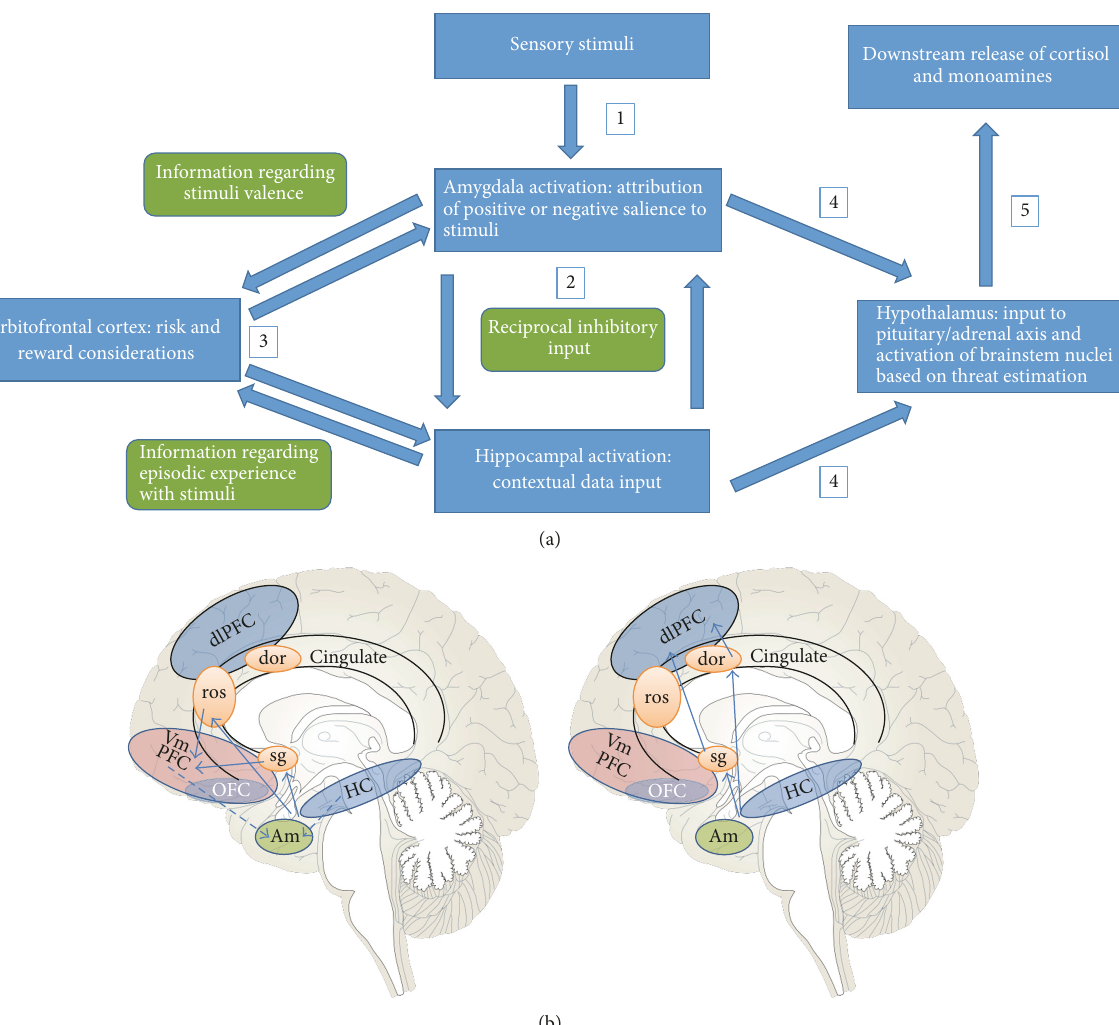
Figure1:Depictionofthesubcortical-corticalcommunicationwhichwillinformwhetherthedlPFCorvmPFCwillbepreferentiallyactivated in response to environmental stimuli. (a) shows how, as the individual perceives an element in the environment (the thalamus is not portrayed in this figure), the amygdala will be activated, and positively or negatively valenced associations will emerge based on past experience. The hippocampus will provide some level of contextual data based on episodic memory, and the OFC will weigh risk and reward considerations based on input from these two structures. Subsequent neuroendocrine responses will ensue, with the hypothalamus being more or less driven to initiate downstream cortisol release, as well as stimulating brainstem nuclei for release of monoamines, depending on the subjective sense of danger felt to be present. (b) illustrates the subsequent higher cortical level activation that will occur after this initial communication. The subcortical-cortical connection will be mediated by the ACC (either ventral or dorsal portions), which will divert activation preferentially towards the dl or vmPFC. Left panel: in instances of lower perceived environmental threat, the vmPFC is activated via portions of the sgACC and the rACC; there is greater inhibitory connection with the amygdala, thus allowing for greater top-bottom mitigation of the fear response (also aided by the inhibitory contextual hippocampal input); more robust development of the vmPFC-amygdala and hippocampus-amygdala control mechanisms can allow for more controlled responses to the environment, even when there may be potential threat, as cognitive control and contextual data will prevent excessive reactivity and stimulus generalization, permitting greater flexibility and hence more adaptive responses. The vmPFC has been shown to be hypoactive in cases of child abuse, major depressive disorder, borderline and antisocial personality disorders, and posttraumatic stress disorder, among others (refer to text for more detail). Right panel: in situations of amygdala- drivenbottom-topcommunication,asisseeninanxietydisorders,posttraumaticstressdisorder,andborderlinepersonalitydisorder,portions of the sgACC and the dACC may be preferentially activated and access the dlPFC, resulting in excessive cognitive control, attempts to suppress distressing memories, and lack of attunement with one’s own emotional response, given the lack of inhibitory feedback onto the amygdala; in (b), solid lines represent excitatory connections and dashed lines, inhibitory connections. dlPFC = dorsolateral prefrontal cortex; vmPFC = ventromedial prefrontal cortex; OFC = orbitofrontal cortex; Am = amygdala; HC = hippocampus; Hy = hypothalamus; sg = subgenual anterior cingulate cortex; ros = rostral anterior cingulate cortex; dACC = dorsal anterior cingulate cortex. The sgACC has connections to both the vmPFC and the dlPFC, the implications of which are described in the text. This depiction is of the medial surface of the brain; the dlPFC and portions of the OFC are located on the superolateral surface of the cerebrum, and their representations here are